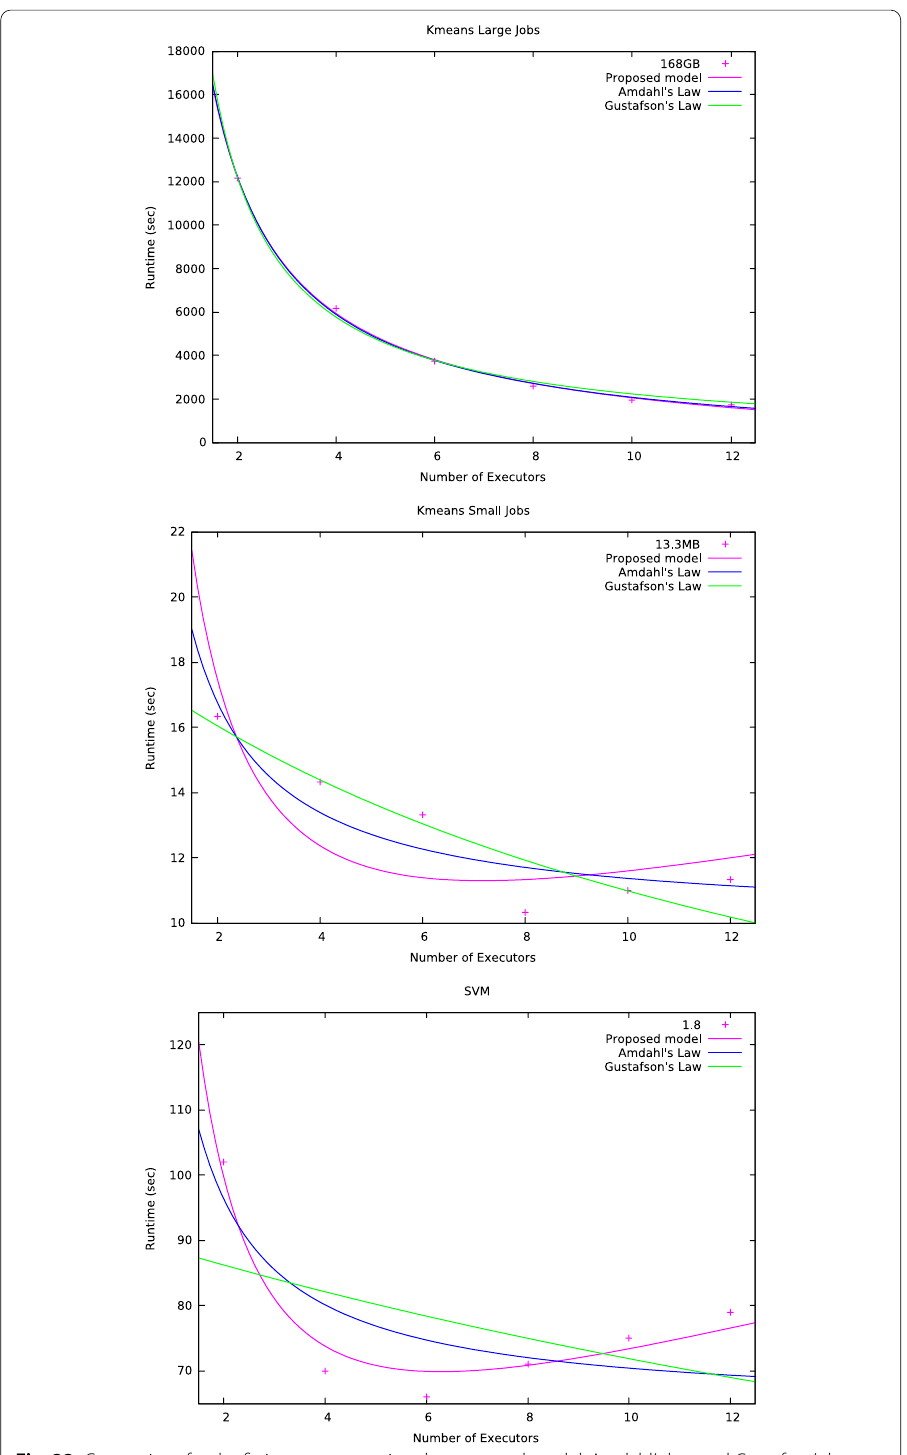
Fig. 22 Comparison for the fitting accuracy using the proposed model, Amdahl’s law and Gustafson’s